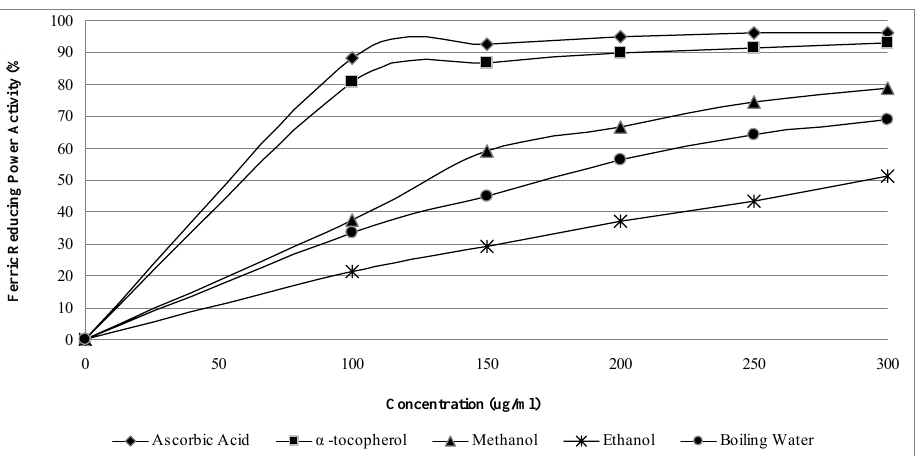
Figure 3. Ferric reducing activity power of C. sativus L. stigma extracts and reference